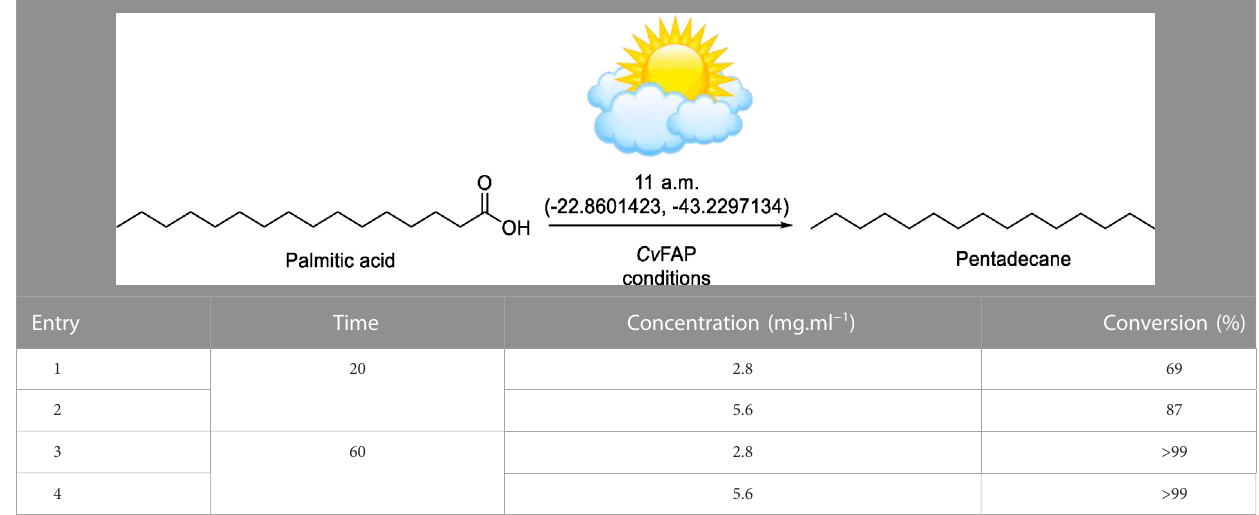
TABLE 3 Palmitic acid photodecarboxylation reaction mediated by Cv FAP on cloudy conditions.